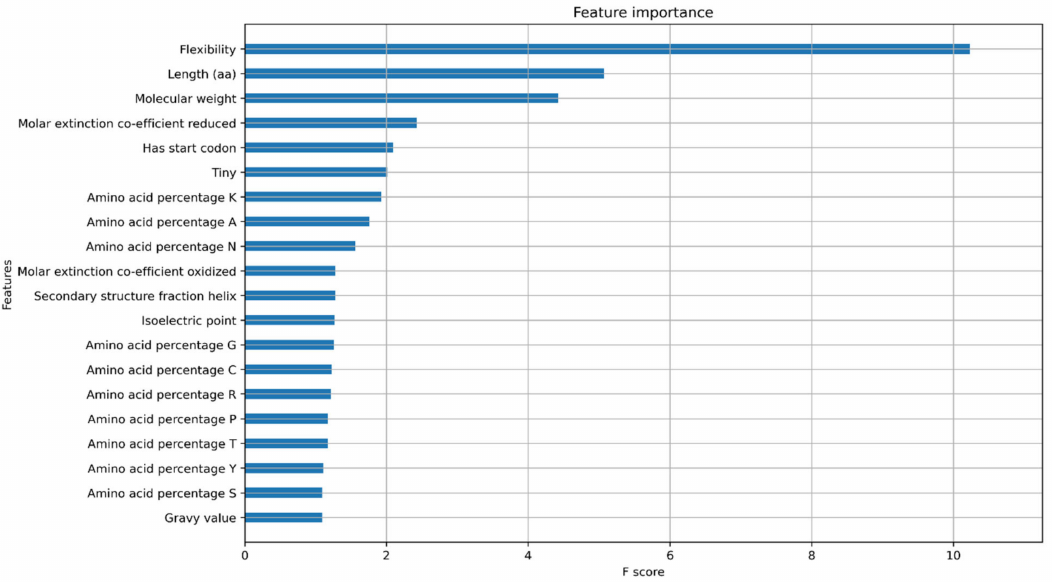
Figure 4. Feature importance Gain plot for XGBoost protein classifier model showing the top 20 features contributing to the